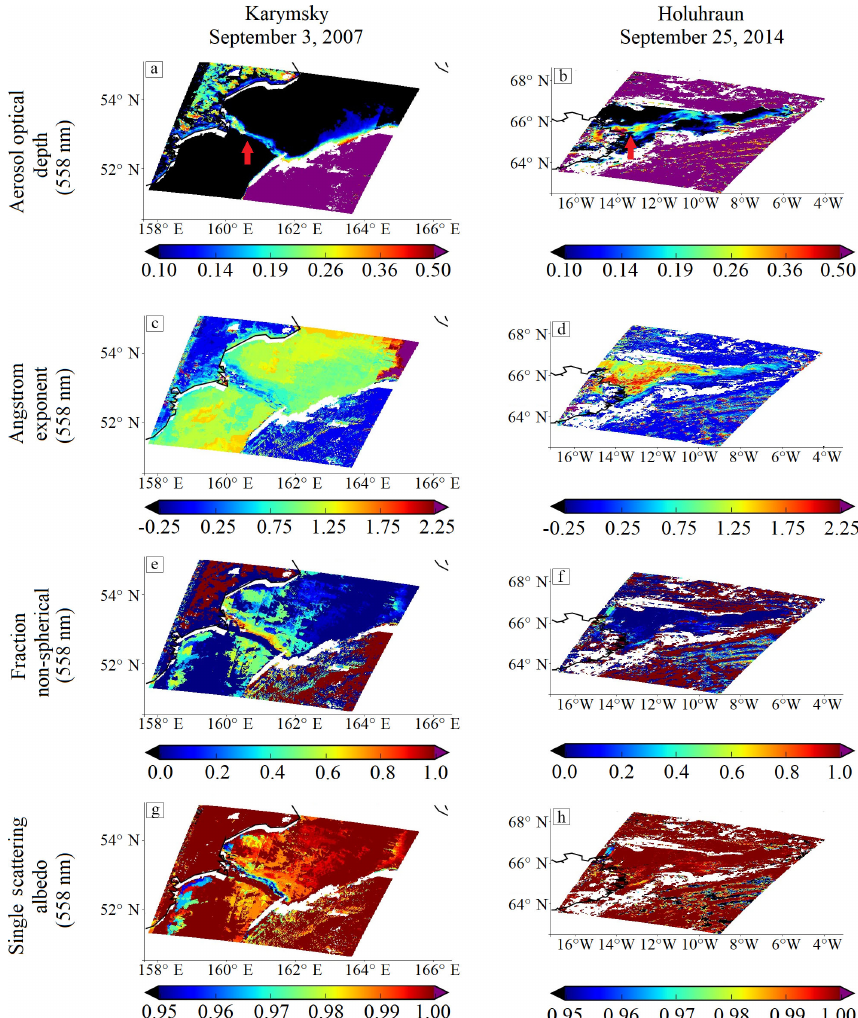
Figure 5. MISR research aerosol (RA) algorithm retrievals of aerosol optical depth ( a , b ), Ångström exponent ( c , d ), fraction of non-spherical particles ( e , f ) and single scattering albedo ( g , h ) for a plume emitted from Karymsky volcano on 3 September 2007 (orbit: 41003; path: 97; blocks: 47–48); and an SO 2 -rich plume from the 2014–2015 Holuhraun eruption, Iceland, emitted on 25 September 2014 (orbit: 78567; path: 214; blocks: 37–38). Red arrows indicate plume locations in panels (a) and (b)